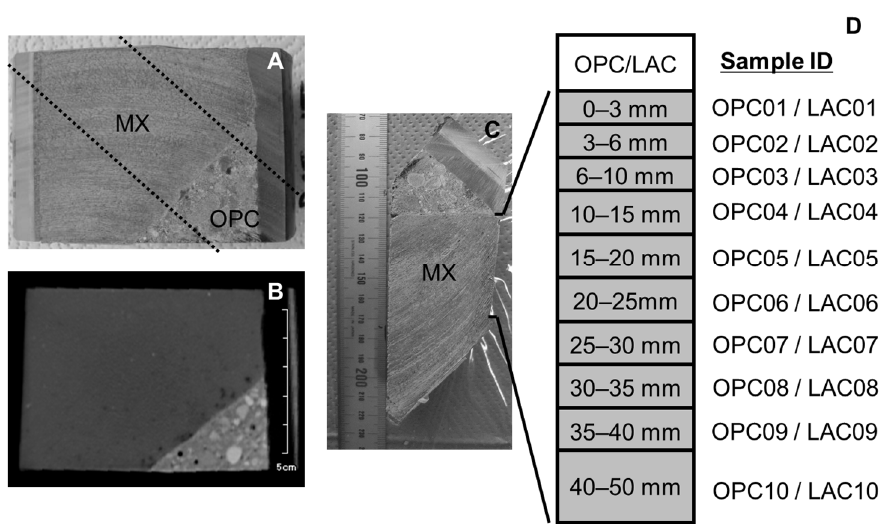
Figure 2. Core sample of BCI-15. ( A ) Photo of core sample, ( B ) X-ray CT image of core sample, ( C ) photo of core sample after cutting along the dotted line in ( A ), and ( D ) division thickness of bentonite and sample ID.